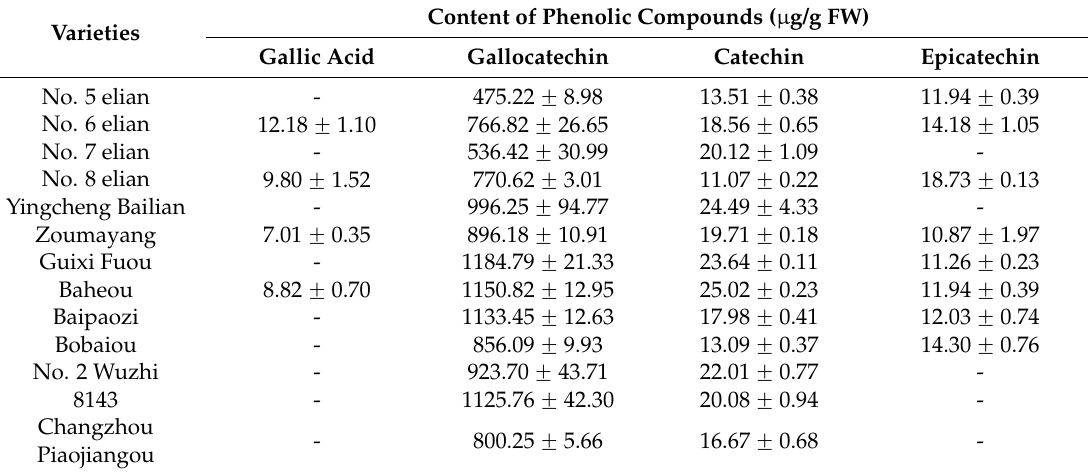
Table 2. Contents of individual phenolic compounds in the fleshes of lotus root